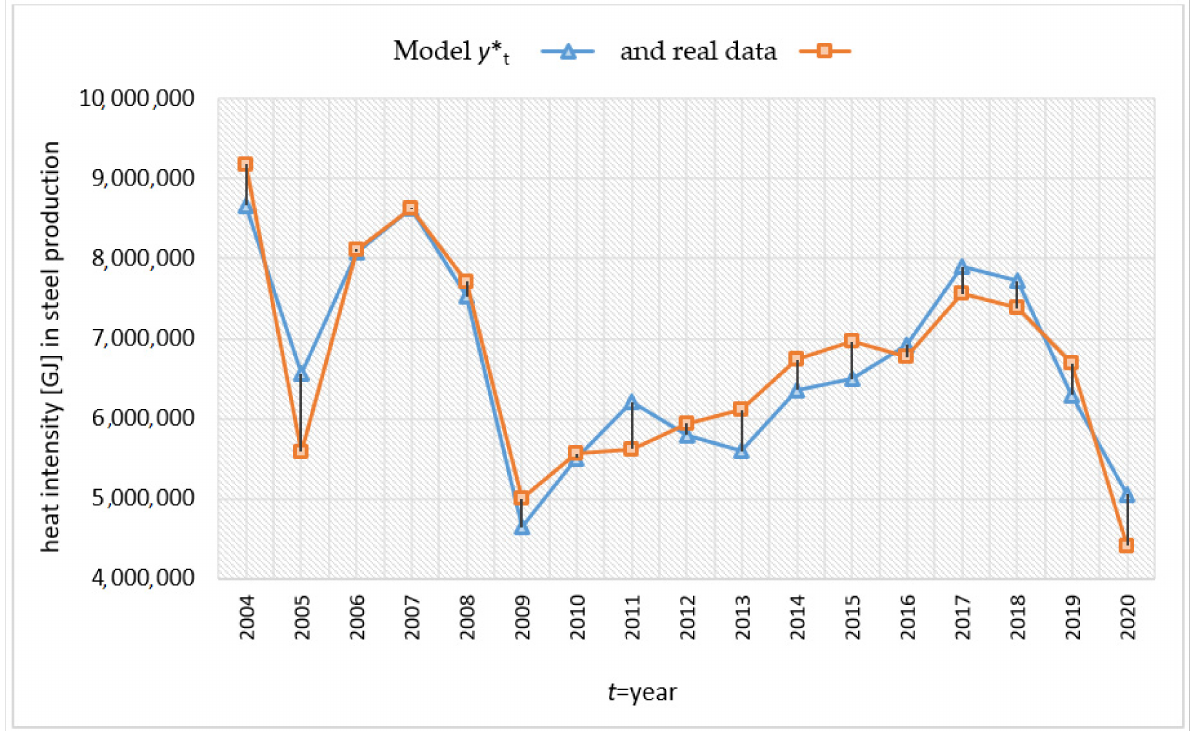
Figure 7. Model: y * t = − 5,290,326 x 1 t + 929.276 x 2 t + 64,352.28 for Polish steel industry for T: from